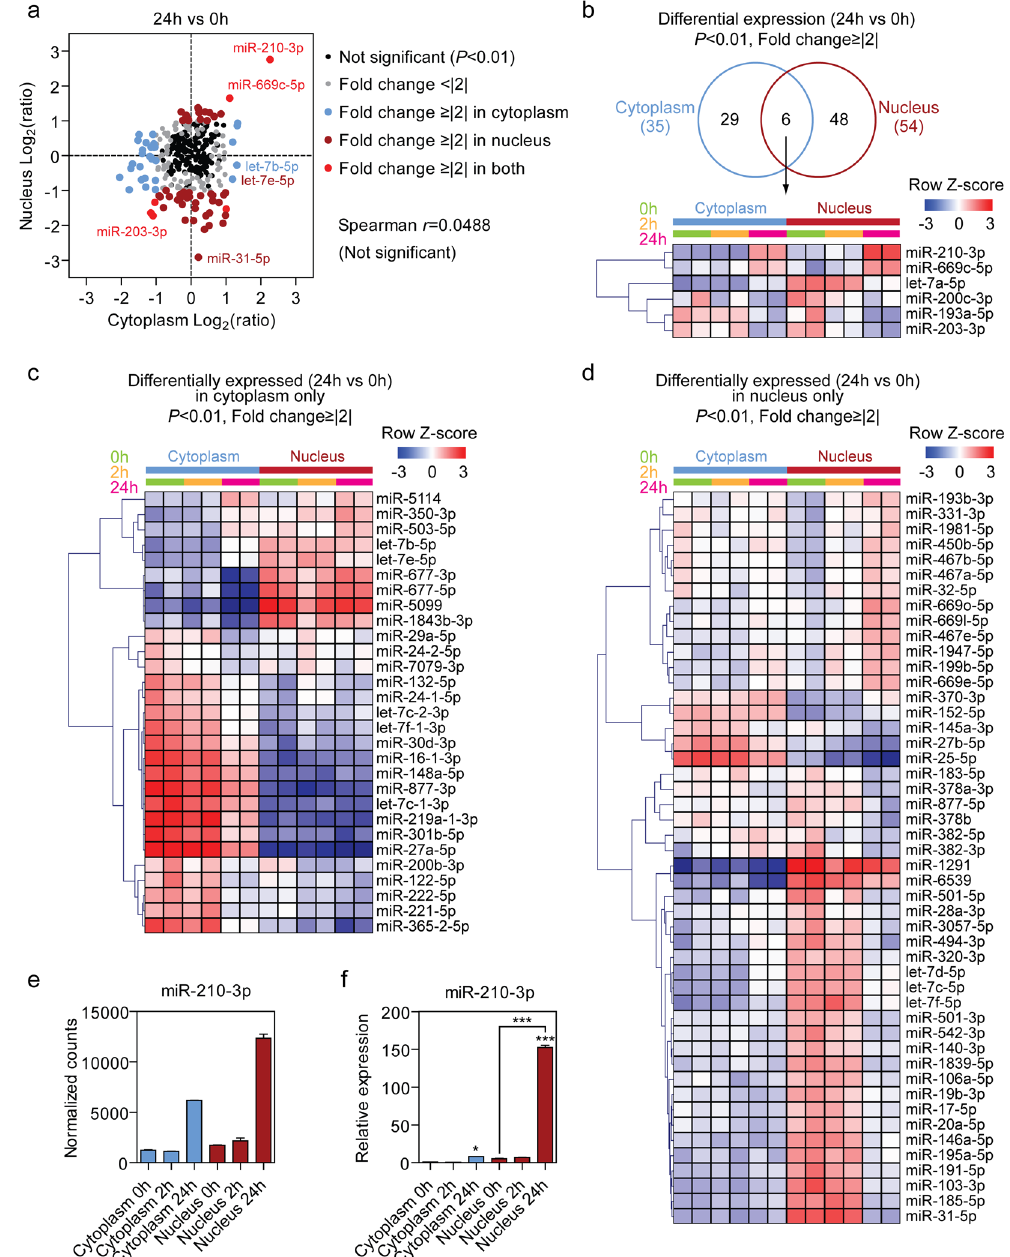
Figure 3. Differential expression of nuclear and cytoplasmic miRNAs upon hypoxic stimulus. ( a ) Comparison of expression ratios for nuclear and cytoplasmic libraries (0 h vs 24 h hypoxia). No significant correlation was observed between the nuclear and cytoplasmic expression ratios. ( b ) Heatmap of common differentially expressed miRNAs upon hypoxia in both nuclear and cytoplasmic samples. ( c ) Heatmap of the differentially expressed miRNAs in cytoplasmic fraction only. ( d ) Heatmap of the differentially expressed miRNAs in nuclear fraction only. Scale bars show mean-centered log 2 normalized counts (row Z-score) where red and blue indicate higher and lower than mean abundance respectively. ( e ) miR-210-3p was identified to be highly up- regulated upon hypoxia in the nuclear fraction. ( f ) miR-210-3p expression in nuclear and cytoplasmic extracts was validated with RT-qPCR. miRNA-levels were normalized to miR-186-5p levels and the mean value of the Cytoplasm 0 h group scaled to a value of one. Values are mean ± SEM, n = 2 (sRNA-seq), n = 3 (RT-qPCR), * P < 0.05, ** P < 0.01, *** P < 0.001 (one-way ANOVA and Bonferroni post hoc test, statistical comparisons are to the Cytoplasm 0 h group unless otherwise